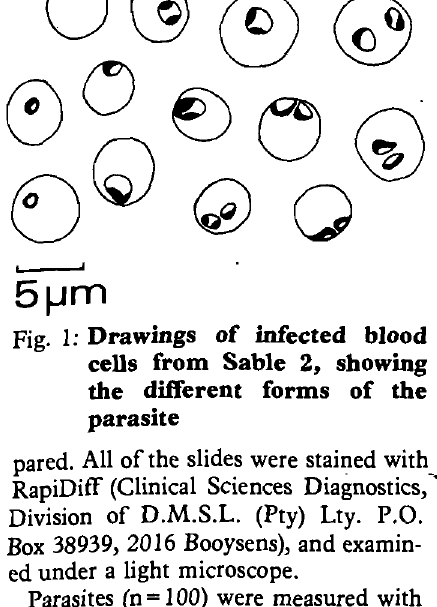
Fig. 1: Drawings of infected blood cells from Sable 2,